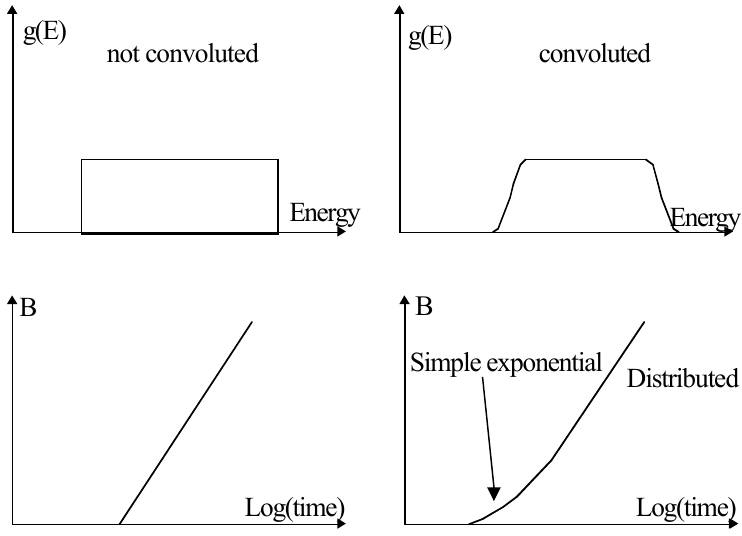
Figure 47. Effective distribution